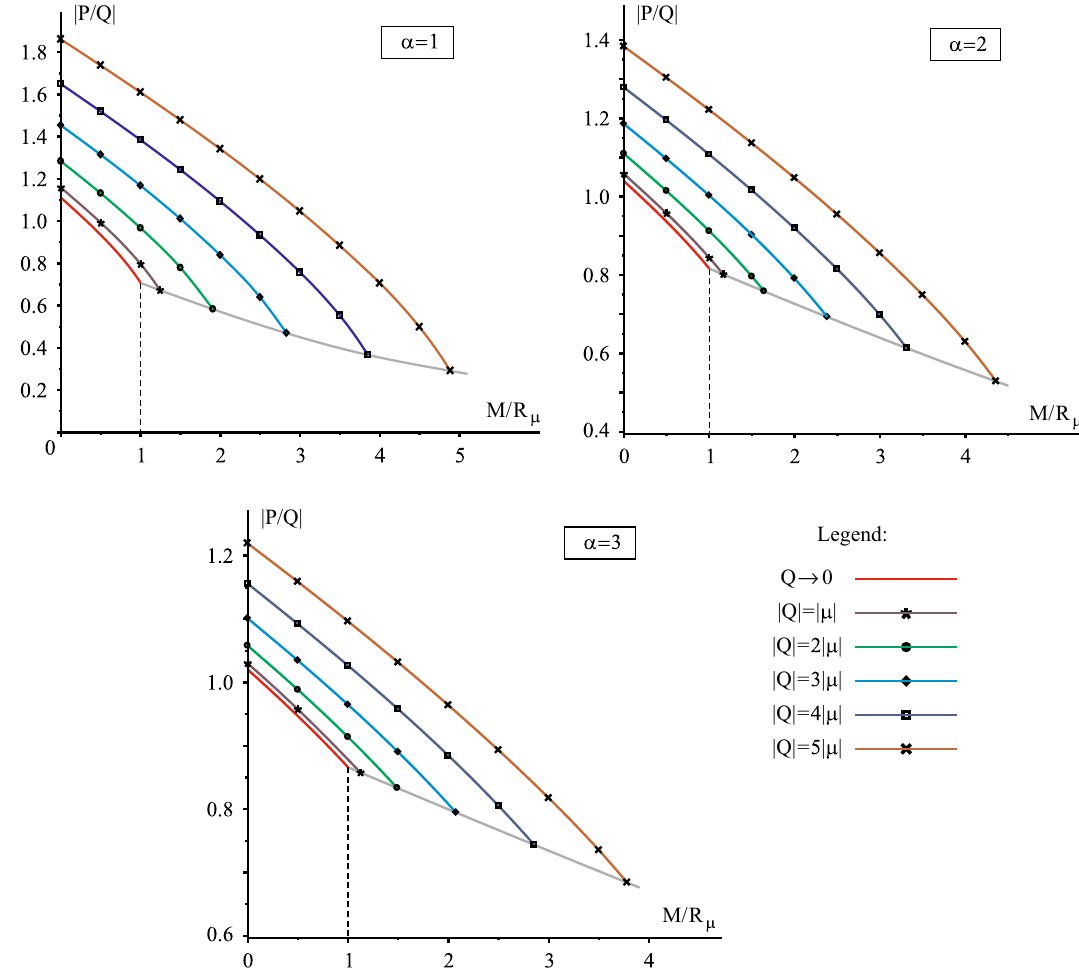
Fig. 3 Dependencebetweentheratio P / Q andthedimensionlessmass M / R μ , where R μ = κμ 2 / 2, for the solution with the regular electric field. The panels relate to specific values of the coupling parameter α = 1 ,..., 3. The first ( left ) line corresponds to the limiting case